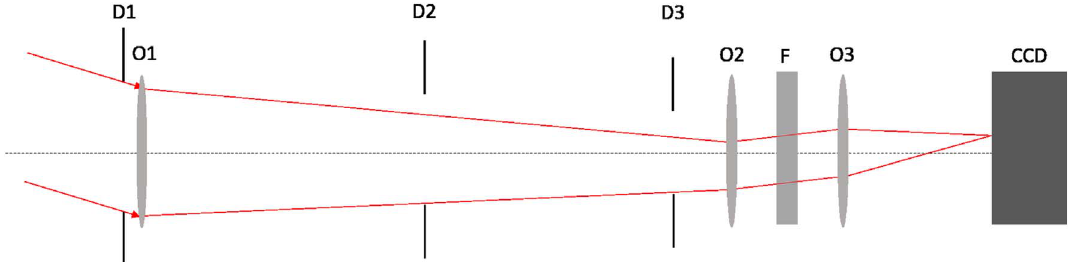
Fig. 1. Schematic of L1 refractor ’ s optics.